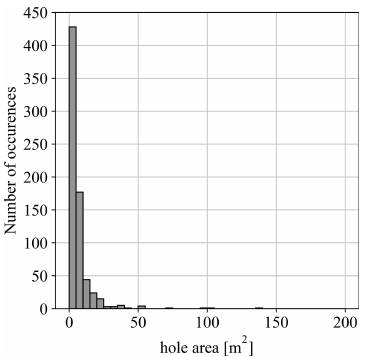
Figure 7. Histogram of hole areas from 708 hole polygons de- duced from the watershed segmentation algorithm applied to the WorldView-2 image acquired on 22 May 2016.